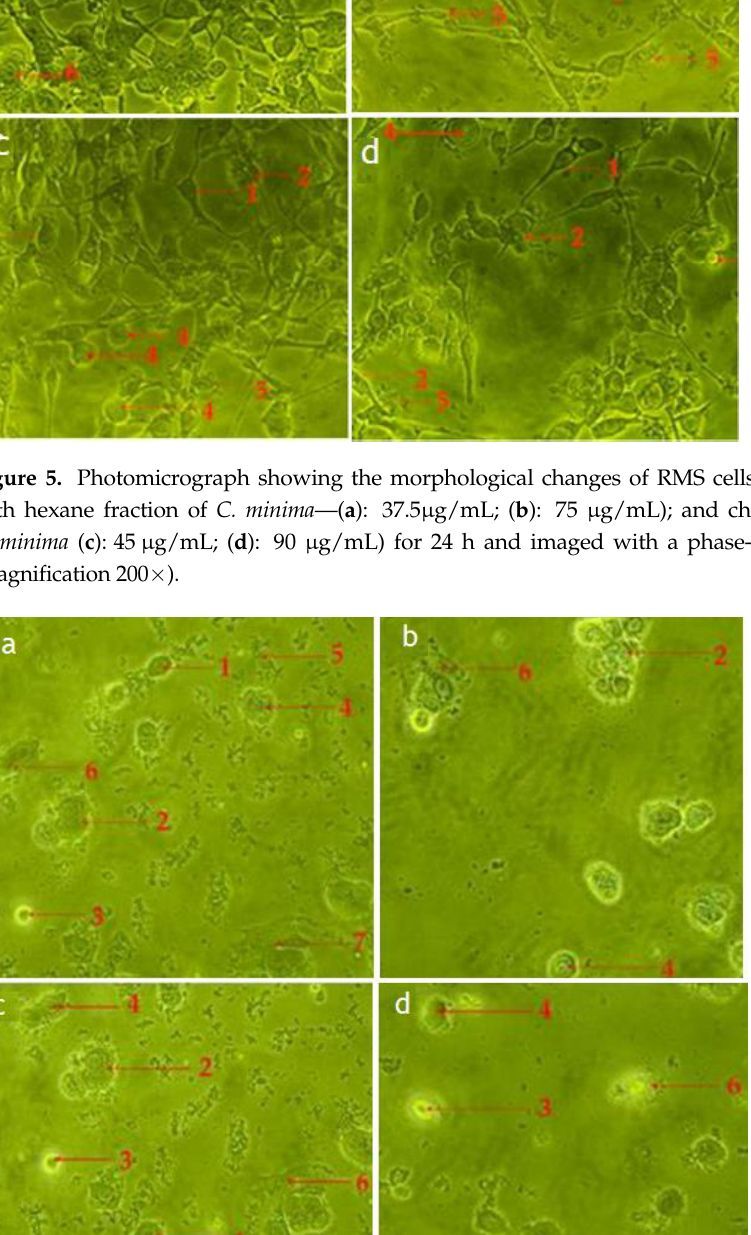
Figure 6. Photomicrograph shows morphological changes of MCF-7 cancer cells. MCF-7 cells treated with hexane fraction of C. minima —( a ): 45 μg/mL; ( b ): 90 μg/mL); and chloroform fraction of C.